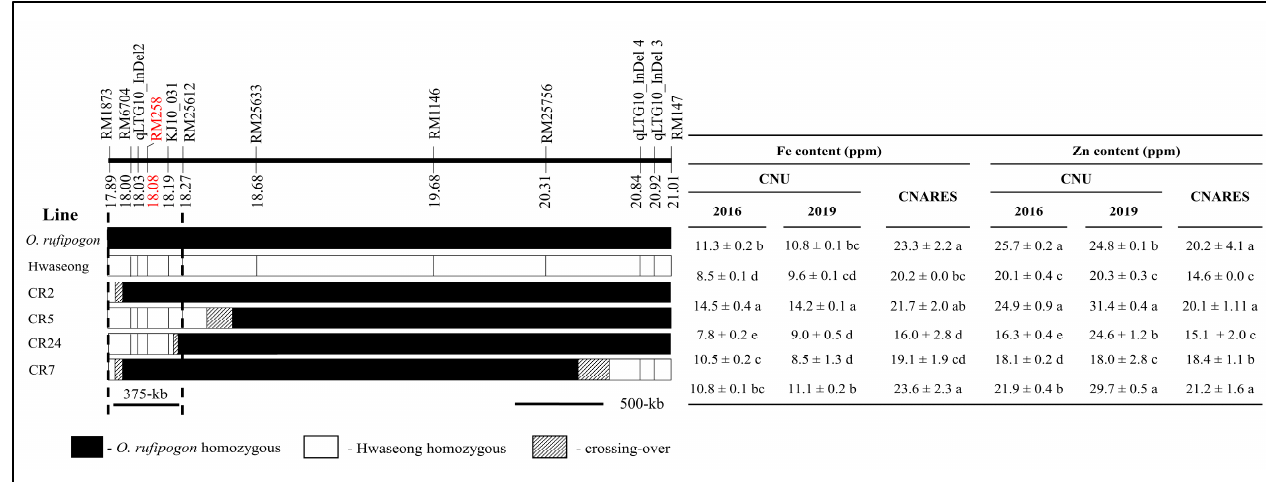
Figure 3. Graphical representation of four ILs and the map of the target region of qFe10 and qZn10 . Physical position (Mbp) is shown under the chromosome. The mean values in each column with different letters are significantly different from each other at p = 0.05 based on Tukey’s test. Values represent mean ± standard deviation of triplicate (CNU) and duplicate (CNARES) measurements. Table 3. Iron content in the root and shoot of rice genotypes grown under -Fe and +Fe treatments.